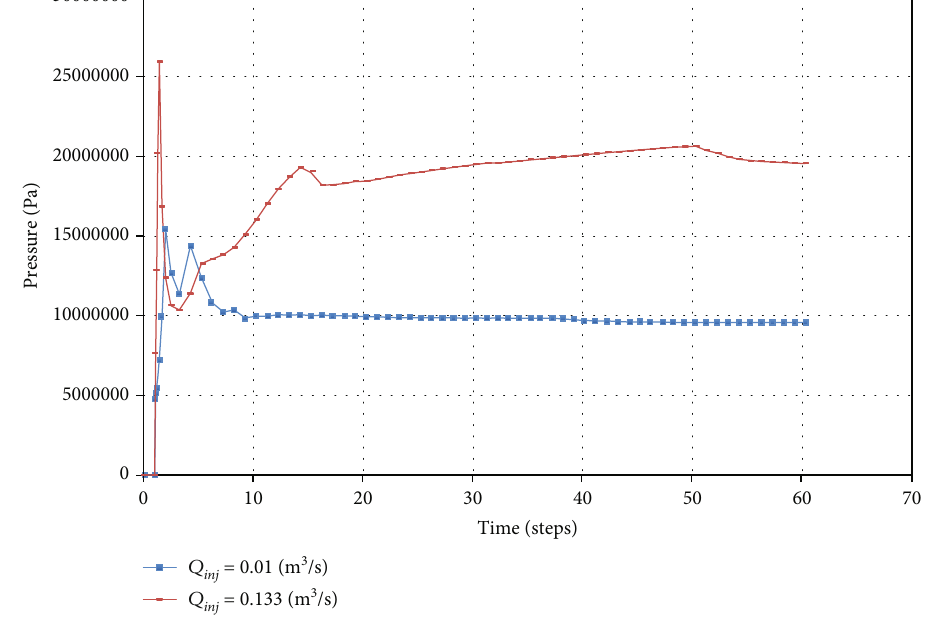
Figure 17: Variation of fracturing pressure over time at di ff erent injection